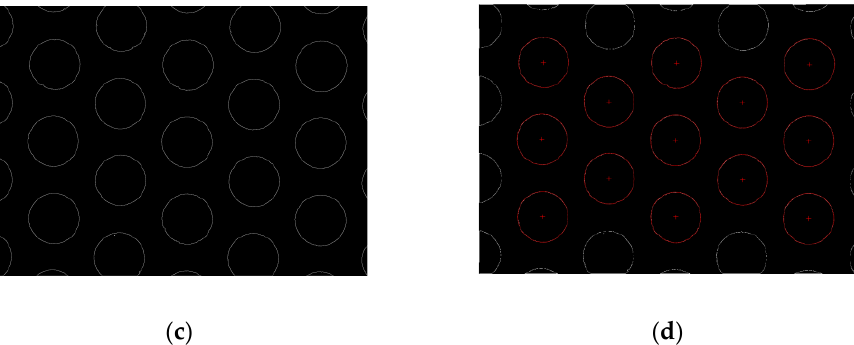
Figure 4. The fitting effect of 145 type of punched steel stripe. ( a ) The image of 145 type of punched steel stripe. ( b ) The image of 145 type of punched steel strip after global threshold processing. ( c ) The image after using morphological edge detection. ( d ) Fitting results after using least squares method.